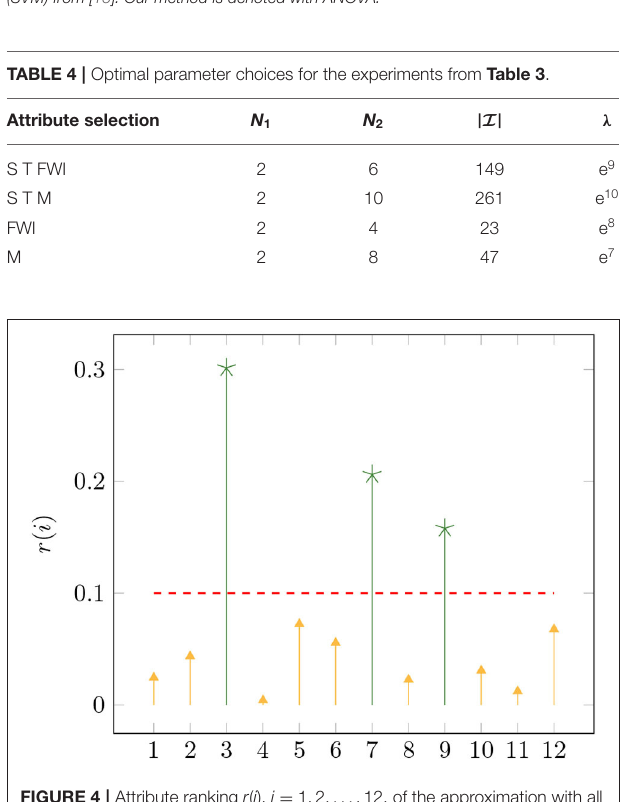
FIGURE 4 | Attribute ranking r ( i ), i twelve attributes using N 1